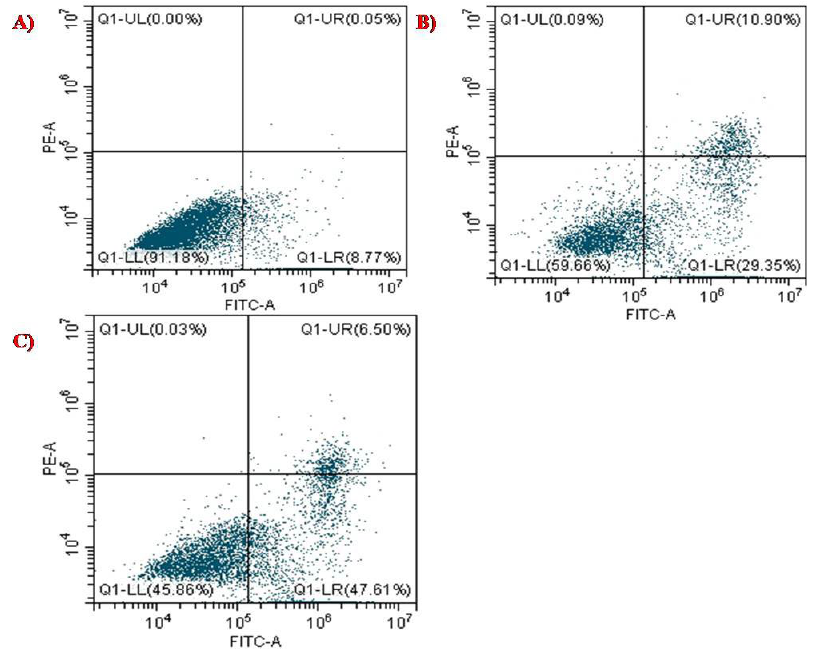
Figure 10. Apoptosis analysis of ( A ) control with dual staining of FITC+PI, ( B ) biosynthesized SeNPs at 60 µg/mL concentration, and ( C ) PTX-chit-SeNPs at 30 µg/mL concentration against HeLa cell lines.